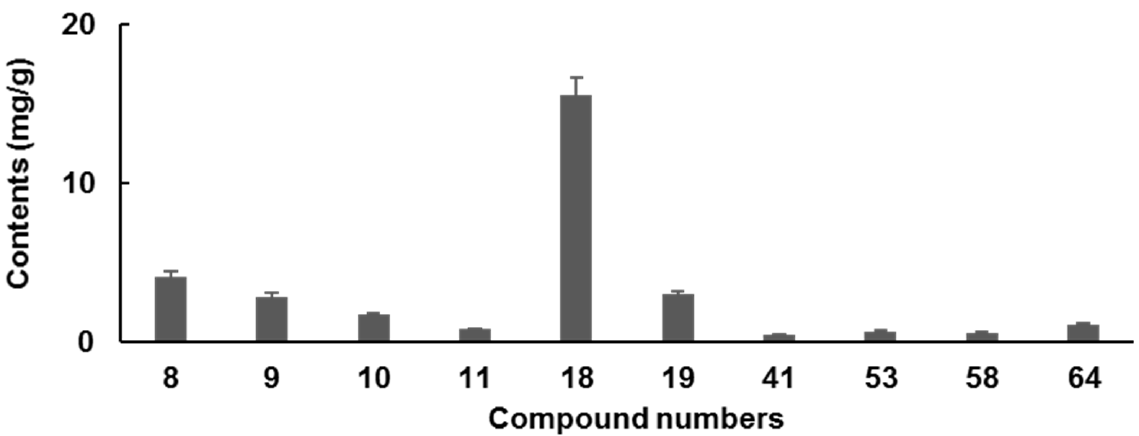
Figure 5. The contents of 10 potential bioactive components in GDL Pill ( n = 6).